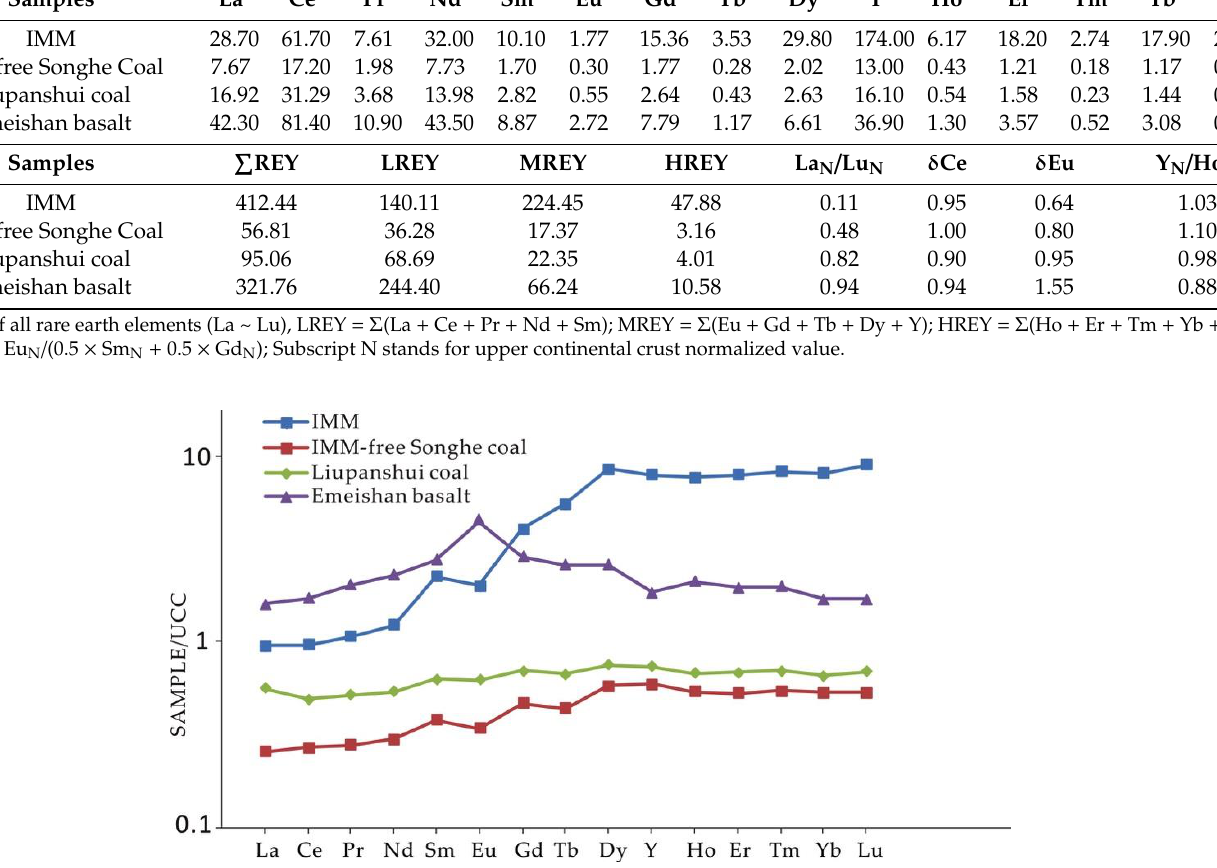
Figure 7. Rare earth elements and yttrium (REY) plots normalized by the average REY content of upper continental crust (UCC, Taylor and McLennan, 1985 [48]).